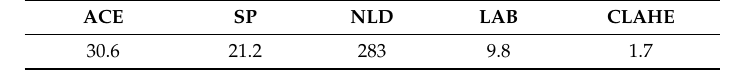
Table 1. Running times (seconds) of different algorithms on a sample image of 4000 × 3000